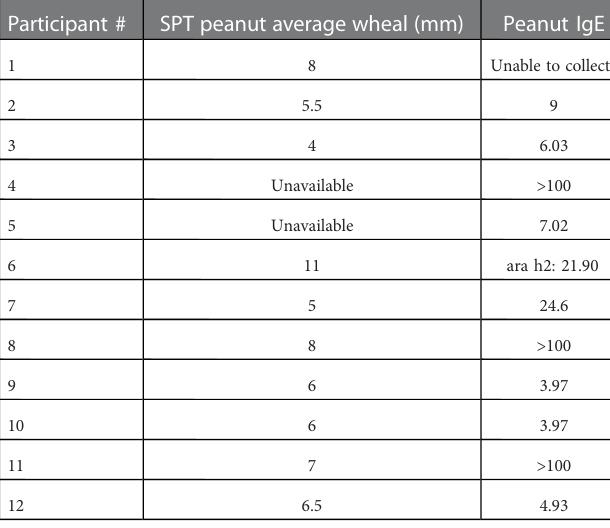
TABLE 1 Skin prick test (SPT) and serum immunoglobulin E (IgE) results from EPIT to OIT